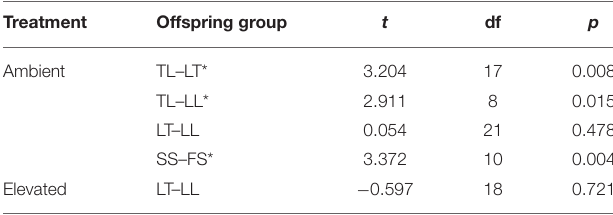
TABLE 6 | Results of t- tests comparing size at the 1-year time point for remaining offspring groups of the Acropora tenuis (T) × Acropora loripes (L) cross, and the Acropora sarmentosa (S) × Acropora florida (F)